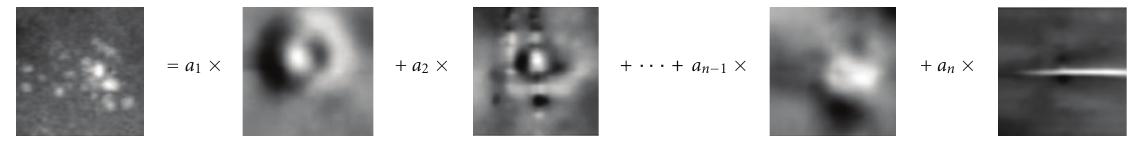
Figure 1: A mammogram region containing microcalcifications expressed as a linear superposition of some ICA-extracted basis